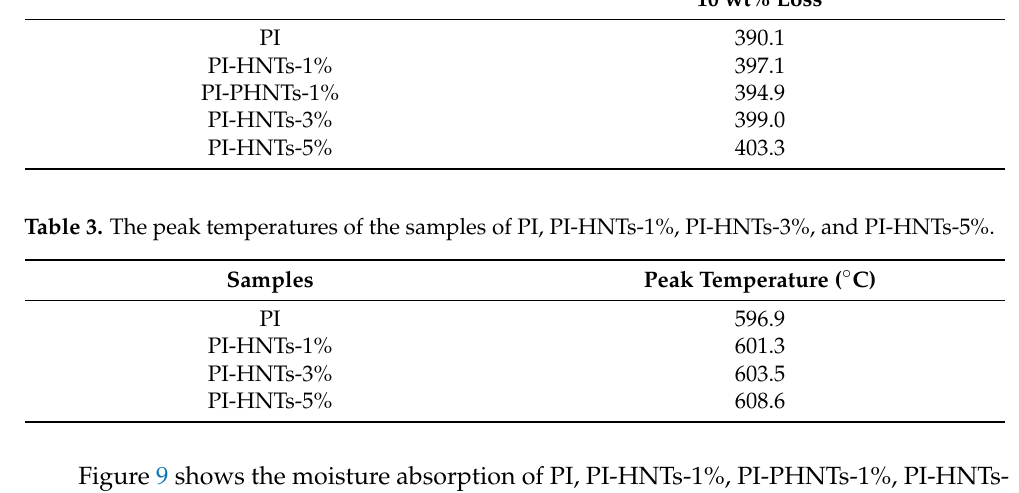
PI-HNTs-3%PI-PHNTs-1%